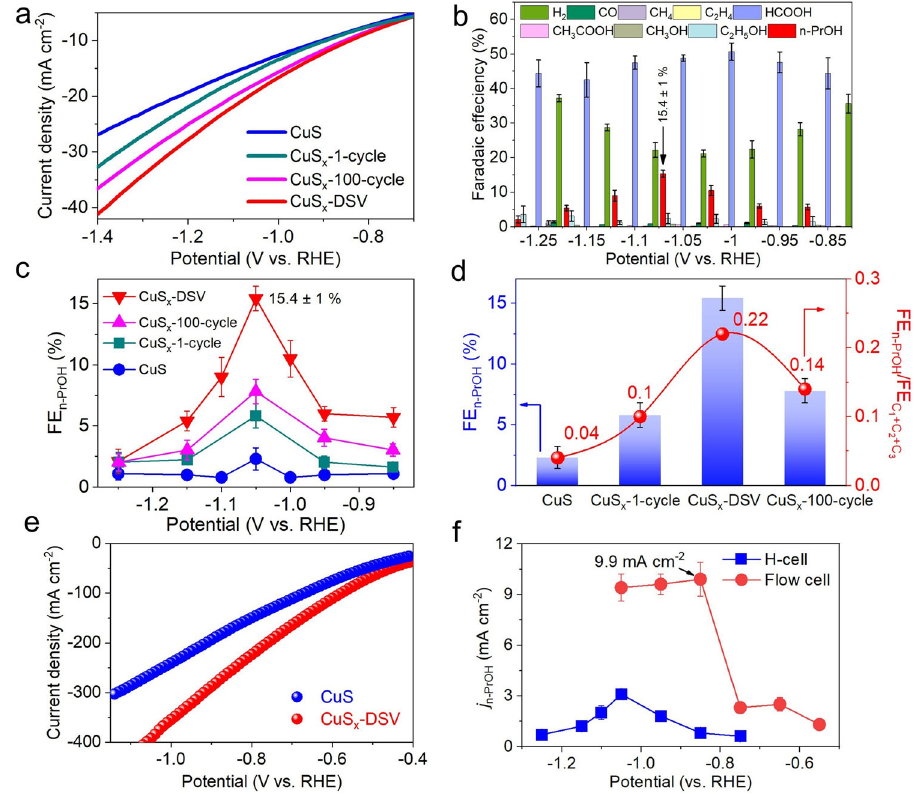
Fig. 4 Electrocatalytic CO 2 RR in H-cells and fl ow-cells. a Linear sweep voltammetry curves of CuS, CuS x -1-cycle, CuS x -DSV, and CuS x -100-cycle catalysts in CO 2 -saturated 0.1 M KHCO 3 aqueous electrolyte with the scan rate at 50 mV s ‒ 1 . b CO 2 RR product distribution using CuS x -DSV catalysts in H-cells. c FE of n-propanol on the four catalysts at different applied potentials. d FE n-PrOH and the ratio FE n-PrOH /FE C1 + C2 + C3 of the four catalysts at − 1.05 V vs. RHE. e Linear sweep voltammetry curves of CuS and CuS x -DSV catalysts in 1 M KOH aqueous electrolyte in fl ow cells. f Partial current densities of n-propanol versus potentials using CuS x -DSV catalyst in H-cells (blue curve) and fl ow-cells (red curve). The data in a – d and e – f were tested in H-cells and fl ow-cells, respectively. Error bars in b – d and f correspond to mean ± standard deviation from three